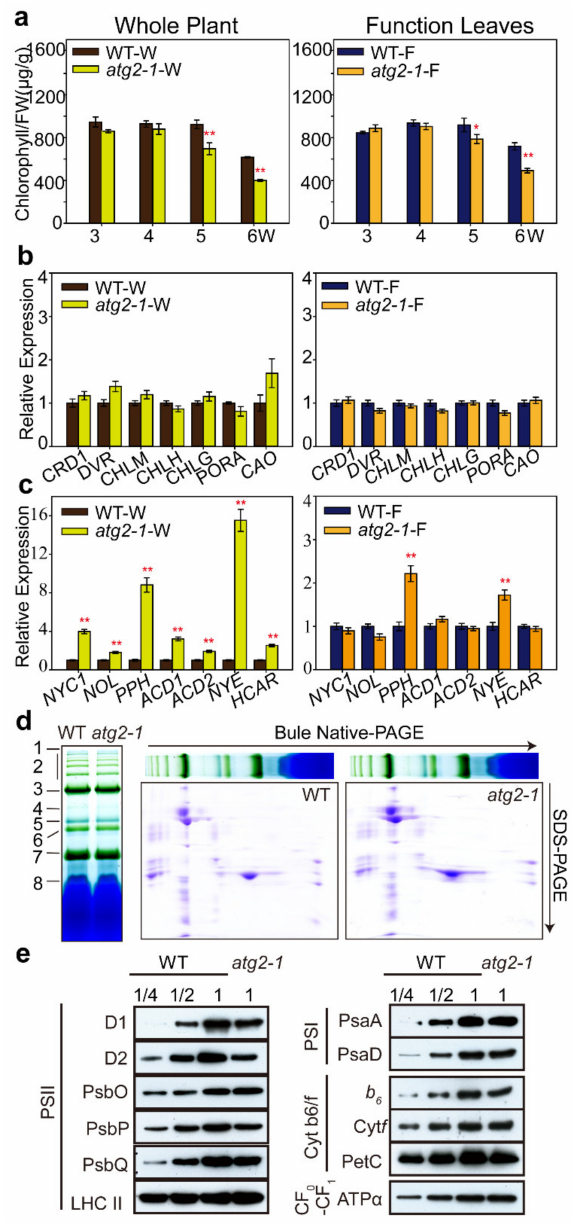
Figure 4. Lack of ATG2 accelerated degradation of chlorophyll and thylakoid proteins. ( a ) The chlorophyll contents of whole plants (left) and functional leaves (right) of WT and atg2-1 mutant plants grown for three to six weeks in soil. Values are mean ± SE ( n = 6 plants). Asterisks show significant di ff erence from the WT plants at * p < 0.05 and ** p < 0.01 (Student’s t test); ( b ) Expression levels of chlorophyll synthesis-related marker genes measured by quantitative RT-PCR in whole plants and functional leaves; ( c ) Expression levels of chlorophyll degradation-related marker genes measured by quantitative RT-PCR in whole plants and functional leaves. The results are shown as mean ± SE from three experiments. Asterisks show significant di ff erence from the WT plants at ** p < 0.01 (Student’s t test); ( d ) Blue native polyacrylamide gel and the subsequent second dimension SDS-PAGE analysis of thylakoid proteins from five-week-old WT and atg2-1 mutant plants (10 wild-type plants and 10 atg2-1 plants were used in this experiment). Annotation of the di ff erent complexes: 1, NDH-PSI; 2, PSII super complexes; 3, PSI monomer, PSII dimer and PSII monomer with LHCII trimers; 4, PSI monomer and CF 1 complex; 5, PSII monomer; 6, LHCII assembly; 7, LHCII trimers; 8, LHCII monomers; ( e ) Analysis of thylakoid membrane proteins accumulation in the five-week-old WT and atg2-1 mutant